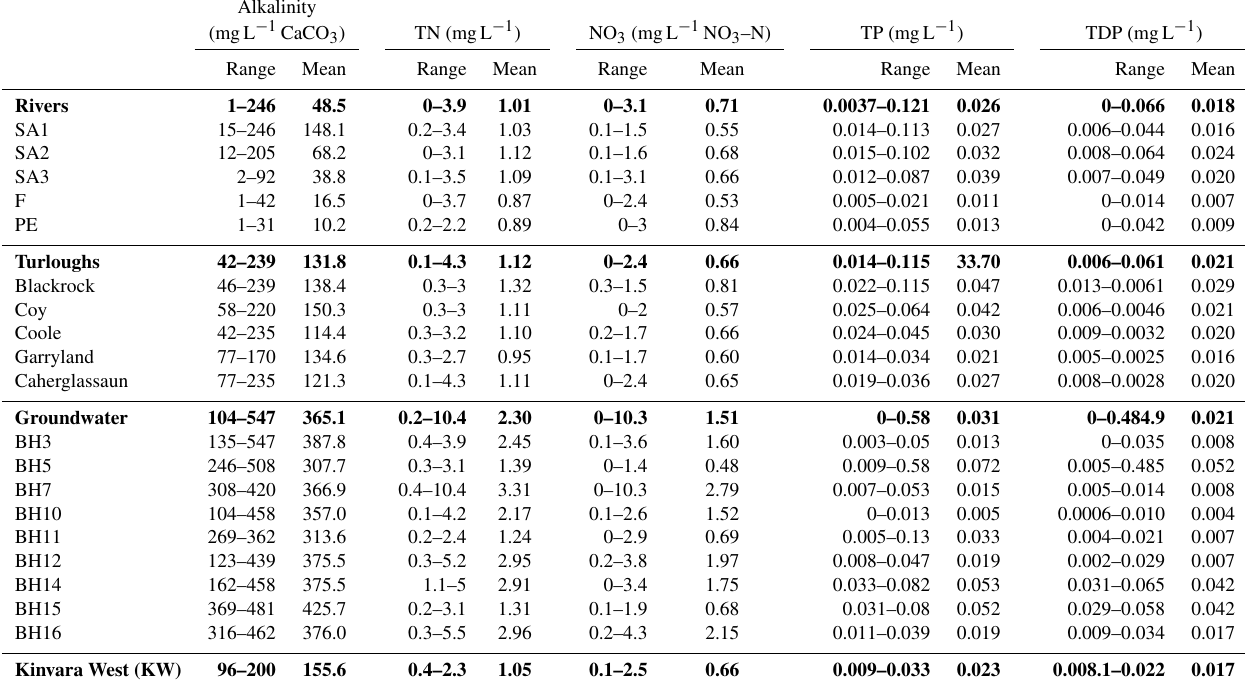
Table 1. Ranges and mean values for alkalinity nitrate (NO 3 ), total nitrogen (TN), total phosphorus (TP) and total dissolved phos- phorus (TDP) for turloughs, groundwater, selected rivers and Kinvara (combined values displayed in bold text) for the period